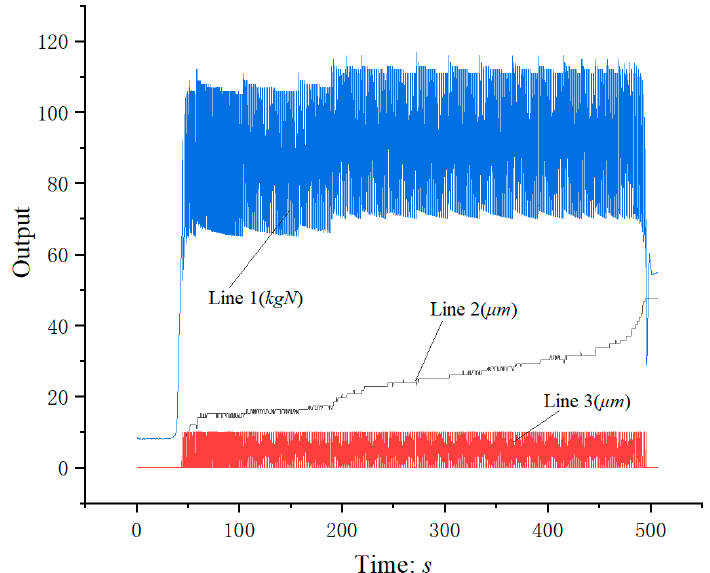
Figure 10. The relationship between output and time. Line 1: Diagram of punch impact force ver- sus time; Line 2: Diagram of punch displacement versus time; Line 3: Diagram of die adjusting displacement with time.